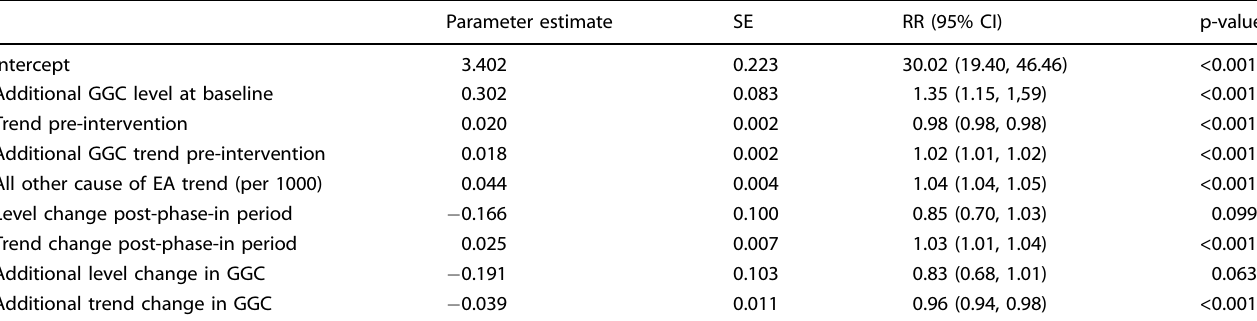
Table 4. Parameter estimates, standard error, relative risk and 95% con fi dence intervals, and p values from the segmented Poisson regression predicting COPD EAs, adjusting for